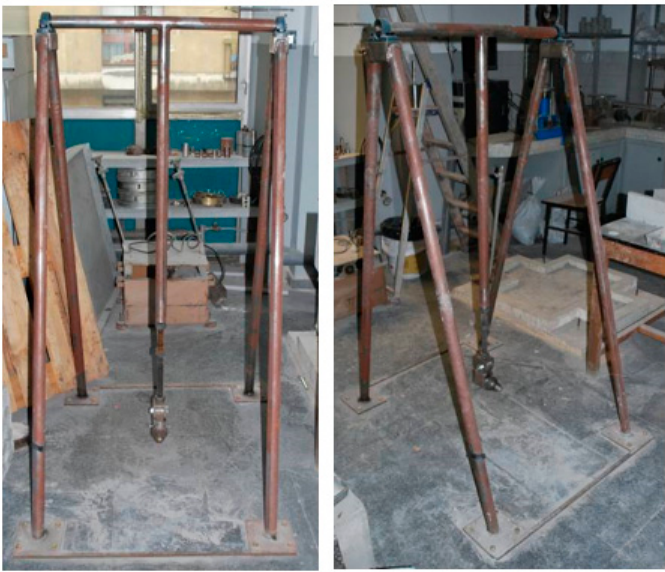
Figure 5. Final prototype.